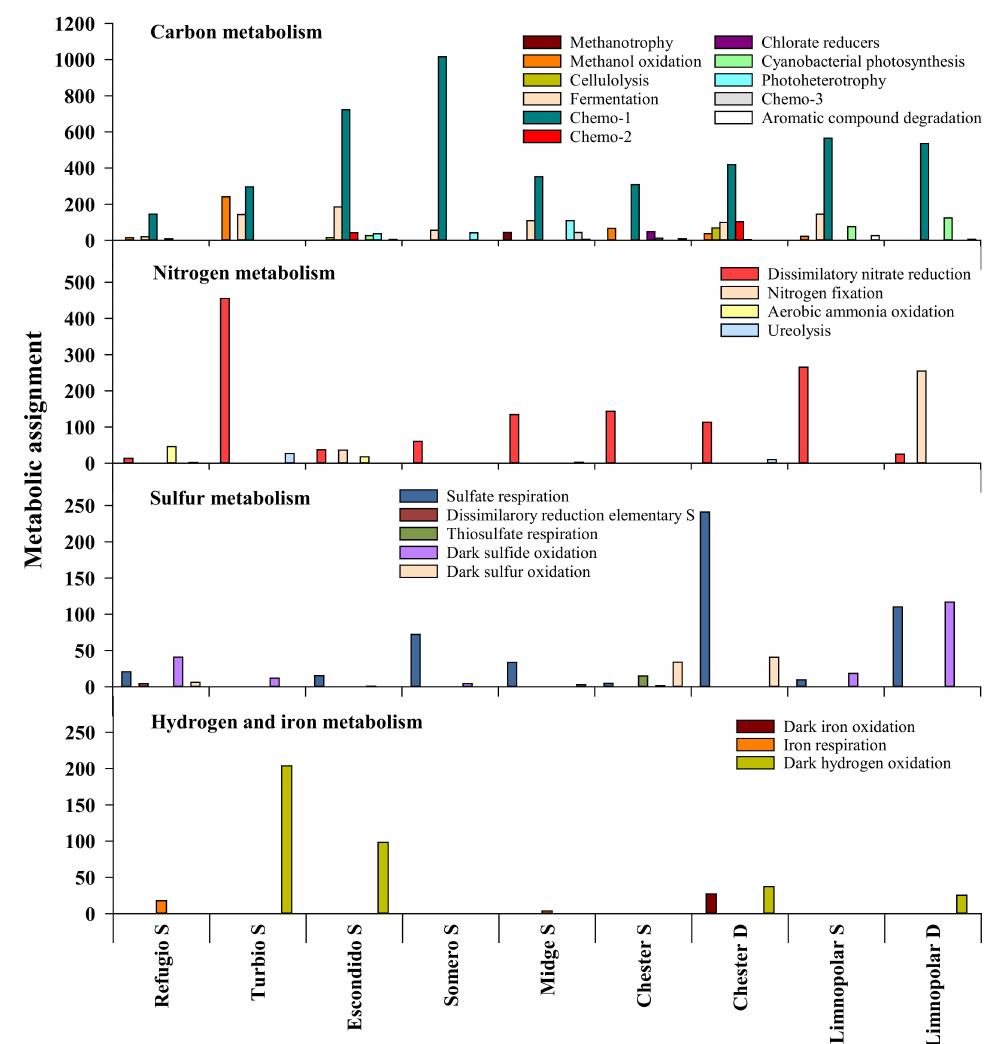
Figure 2. Main metabolisms associated with the biogeochemical cycles of carbon, nitrogen, sulfur, hydrogen, and iron in the different lakes studied in the Byers Peninsula, Antarctica. S stands for the surface sample, and D for the bottom (deep)